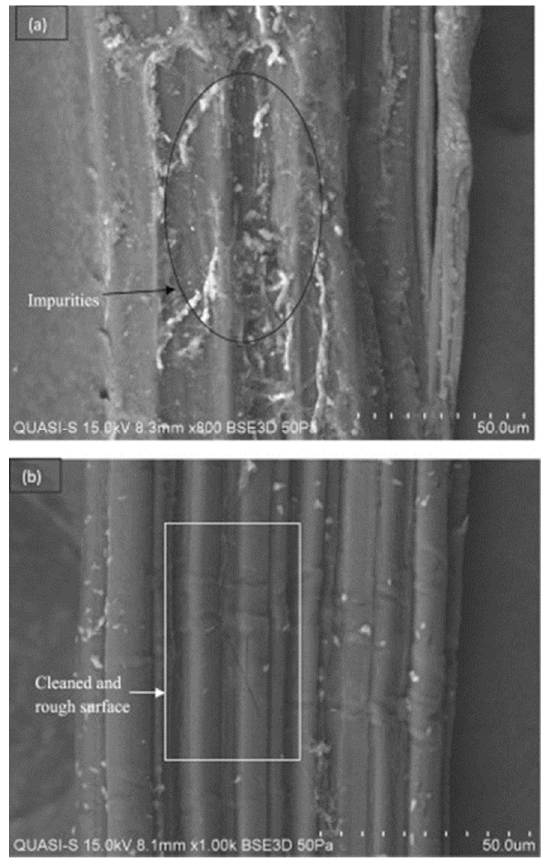
Figure 1. Scanning Electron Microscopy (SEM) micrographs of ( a ) treated and ( b ) untreated kenaf fibers [76].